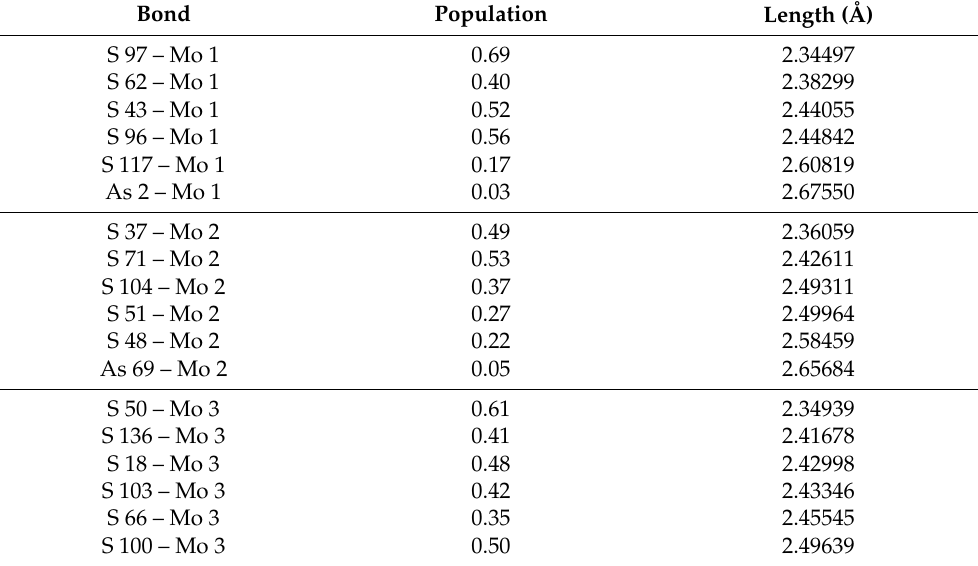
Table A8. Bond populations for mq-GOpt As 2 S 3